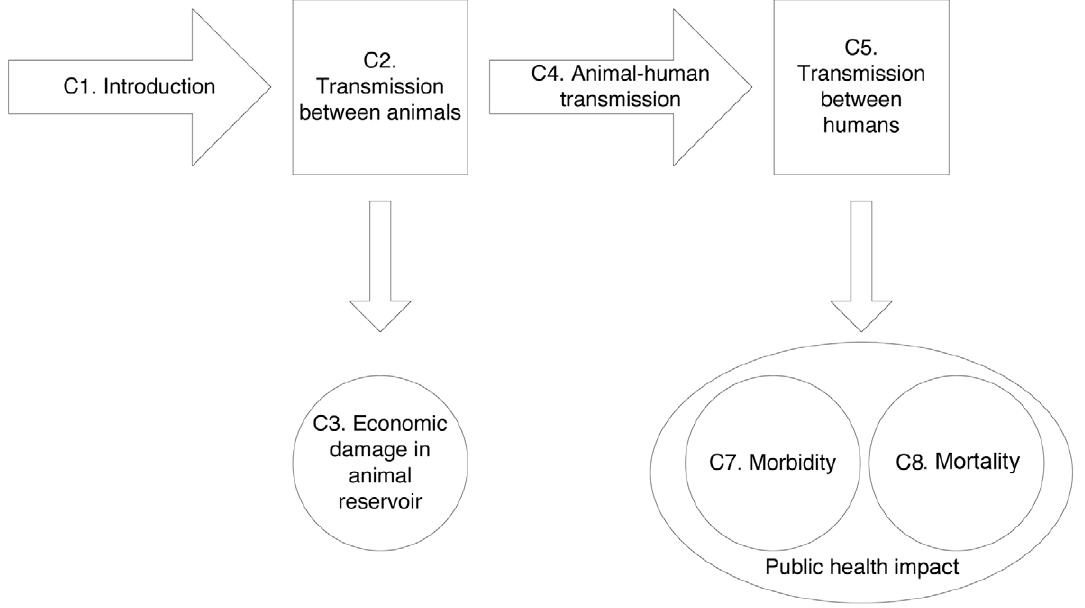
Figure 1. Flow chart of the pathway from introduction of a zoonotic pathogen to public health impact, represented by 7 criteria (C1–C7) from which the risk to public health of emerging zoonoses was derived.